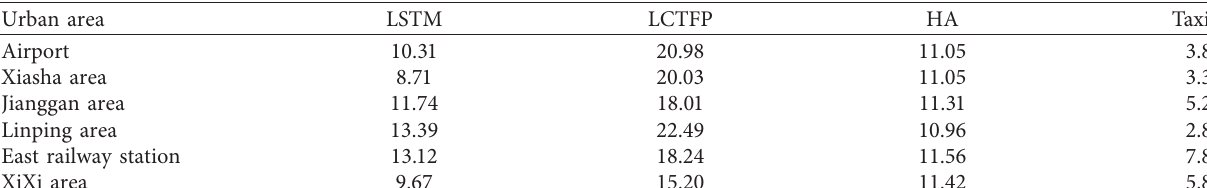
Figure 5: Train loss line chart. Table 2: Comparison of prediction